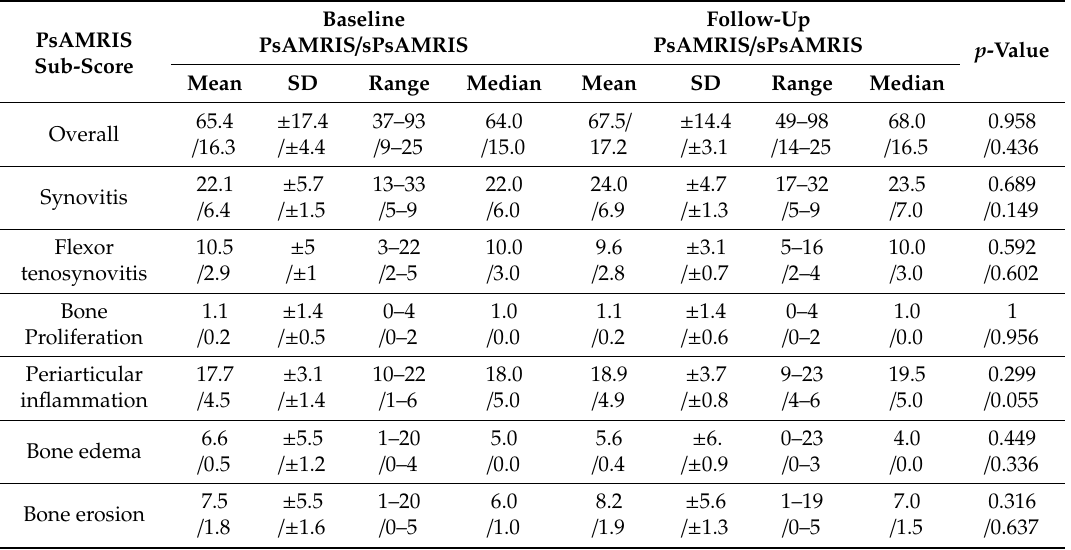
Table 3. Descriptive analysis of PsAMRIS and short (s) PsAMRIS at baseline and at follow-up regarding the overall scores and each sub-score. For each values the mean ± standard deviation (SD), the median and range are